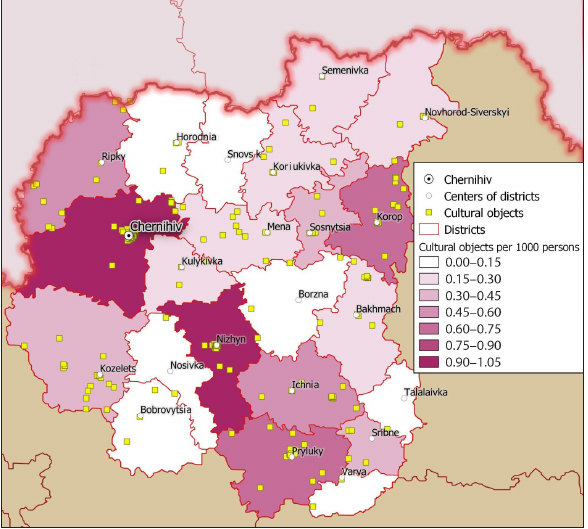
Figure 4. A cartogram showing the number of historical and cultural objects relatively to the number of population in